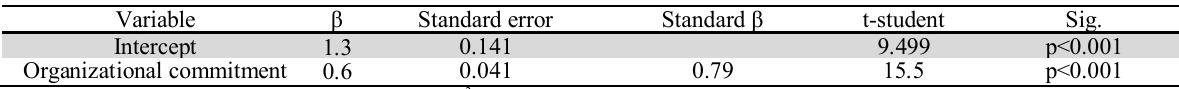
The summary of regression model between perceived organizational change and organizational commitment Variable β Standard error Standard β t-student Sig. Intercept 1.3 0.141 9.499 0.001<p Organizational commitment 0.6 0.041 0.79 15.5 0.001<p